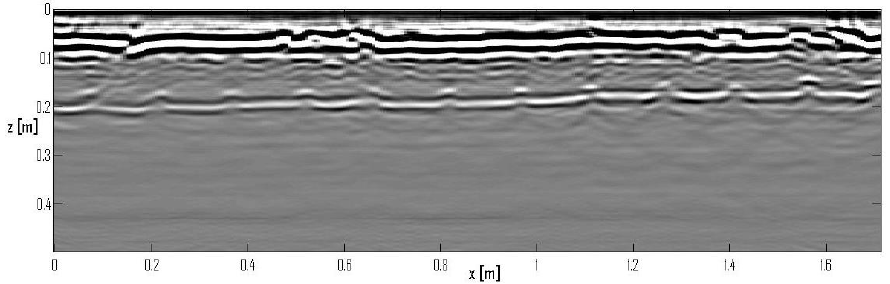
Figure 11. Joined time-depth conversion with vertical variation of the propagation velocity, related to the result of Figure 10.